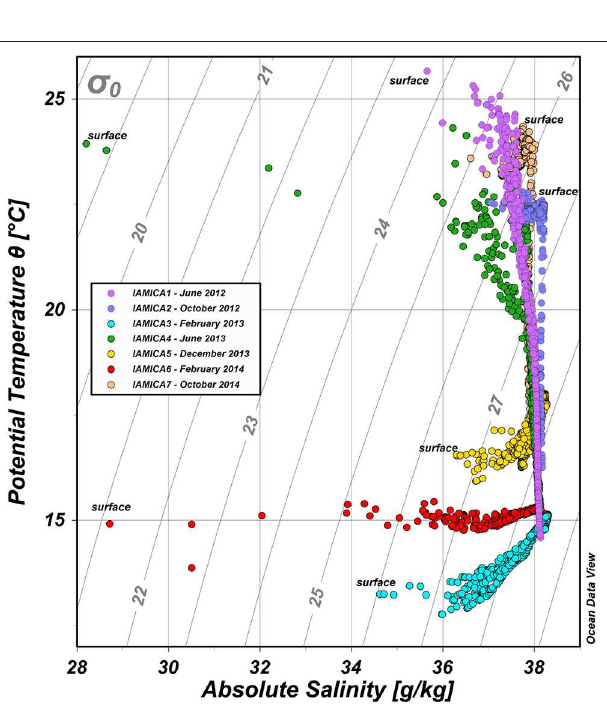
FIGURE 2 | TS diagram for all seven surveys from the surface to the bottom, differently